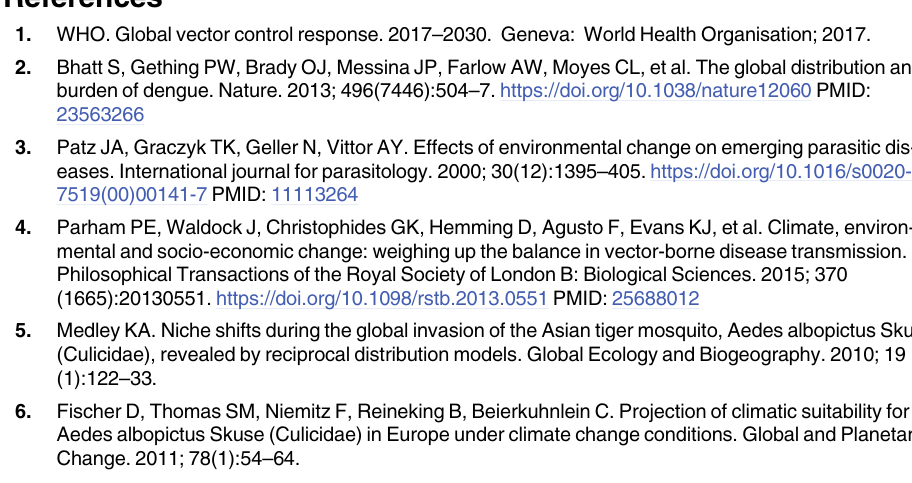
) temperatures for each treatment are Δ